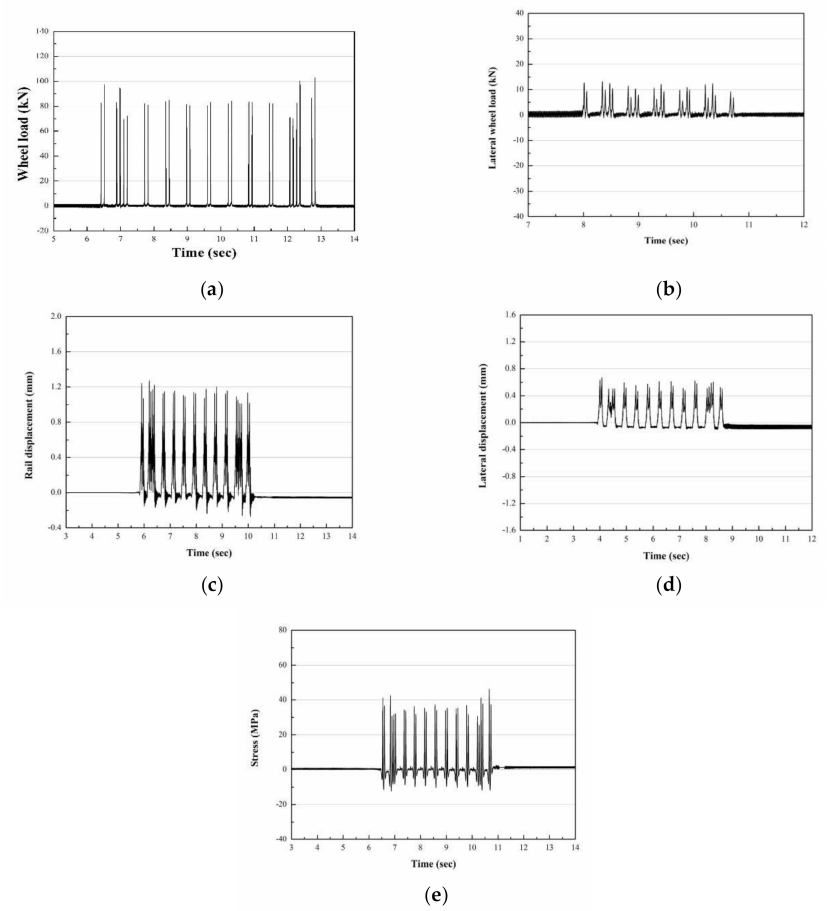
Figure 5. Data for the respective measurement factors (examples): ( a ) wheel load data sample, ( b ) lateral wheel load data sample, ( c ) vertical rail displacement data sample, ( d ) lateral rail displacement data sample, and ( e ) stress data